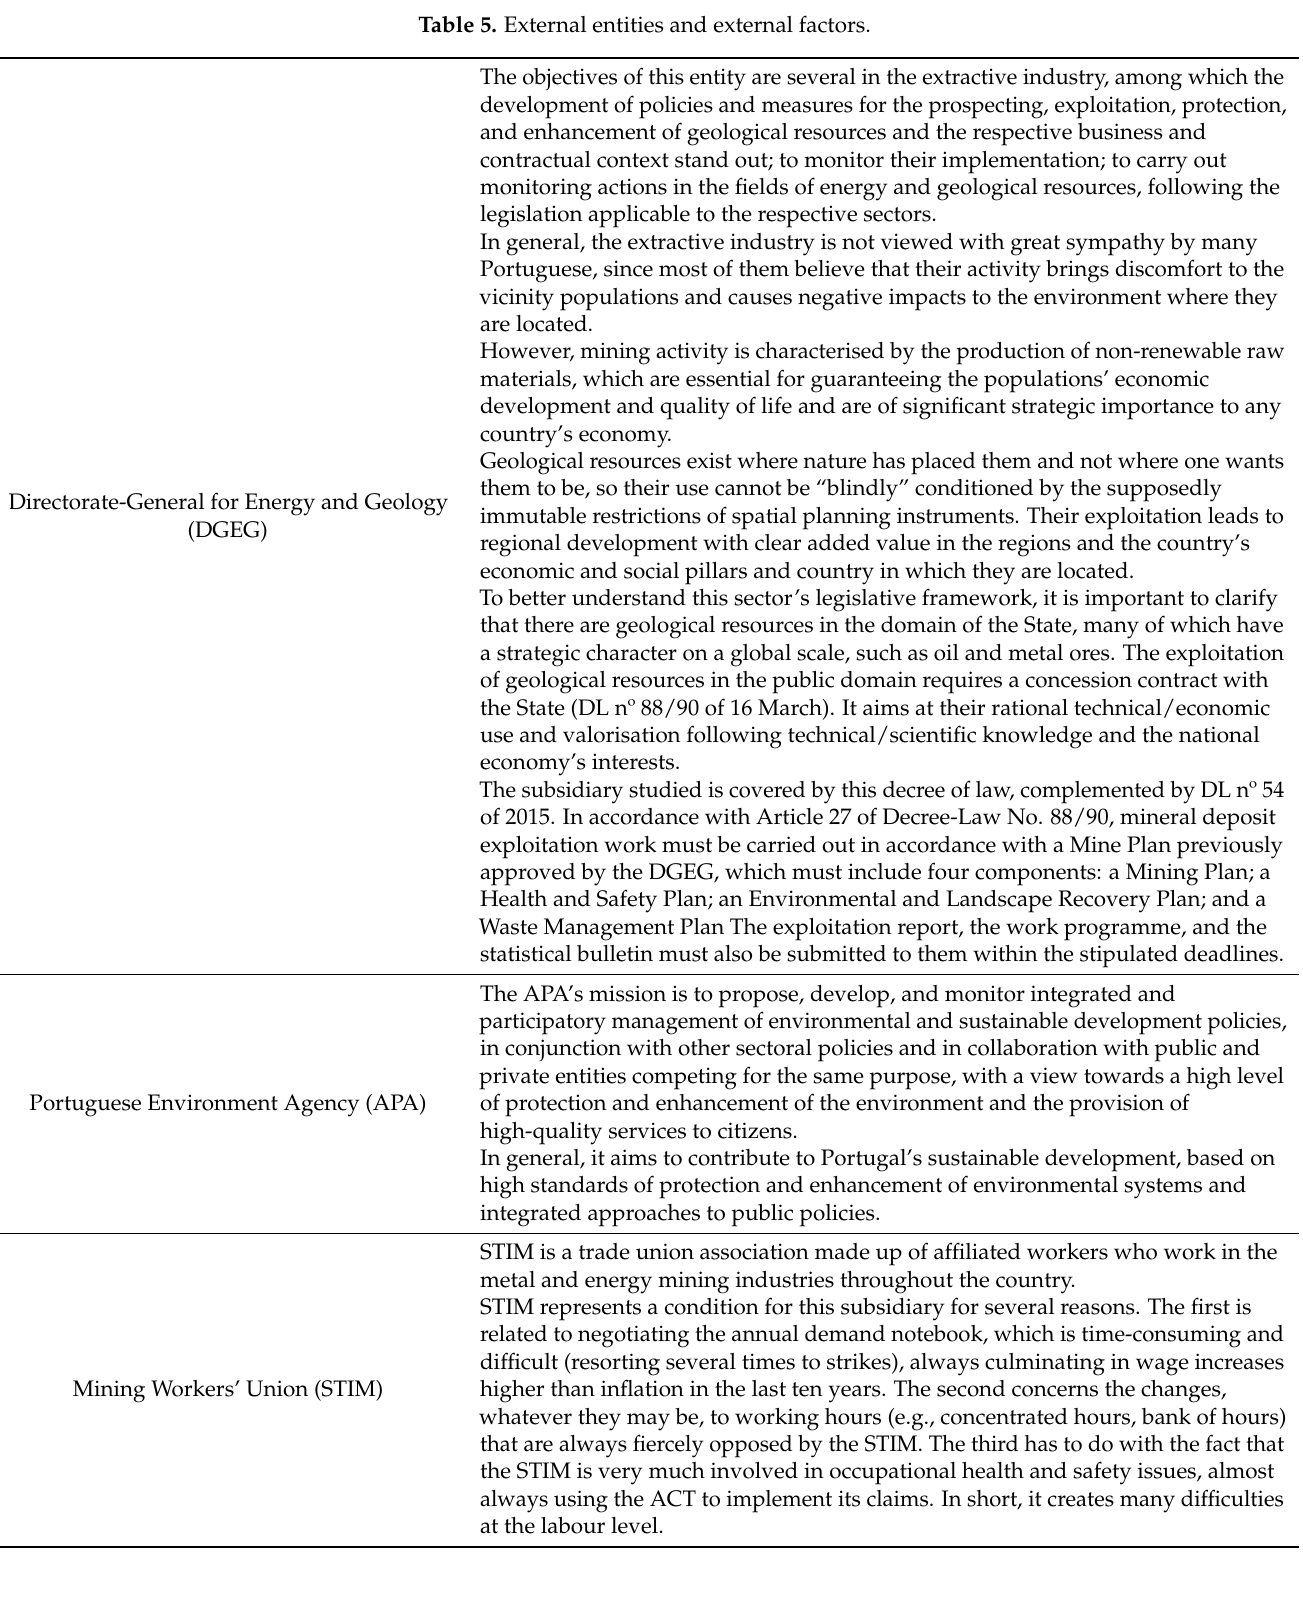
Table 5. External entities and external